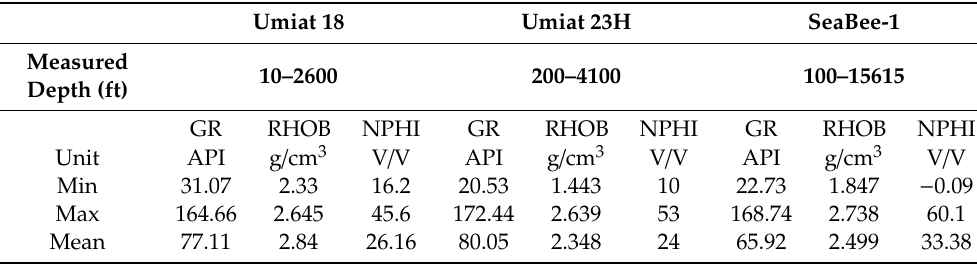
Table 2. The minimum, maximum, and mean values for input logs of the Umiat